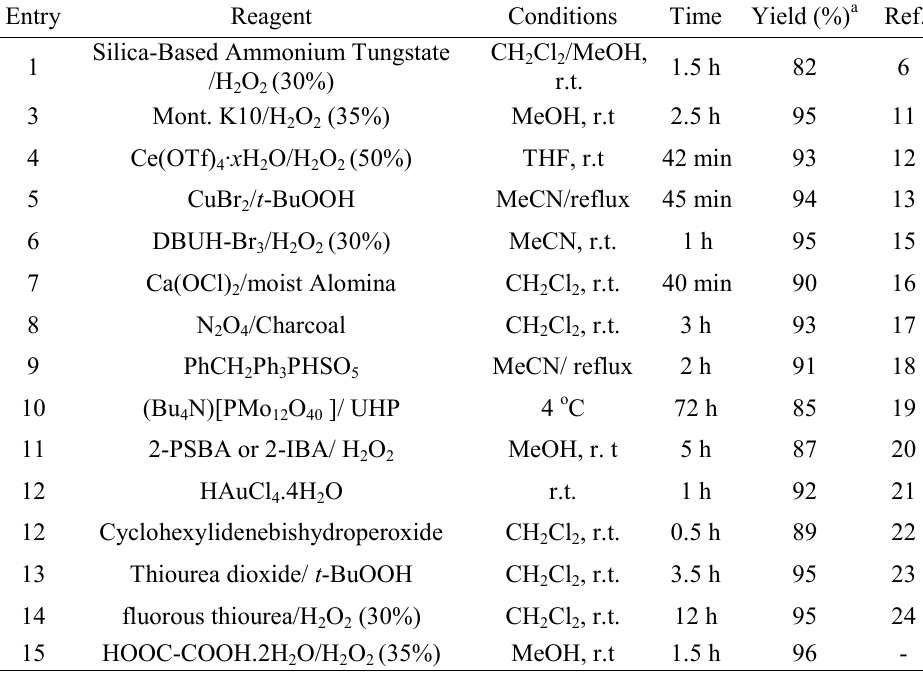
O/H O with some other catalyst for oxidation 2 2 2